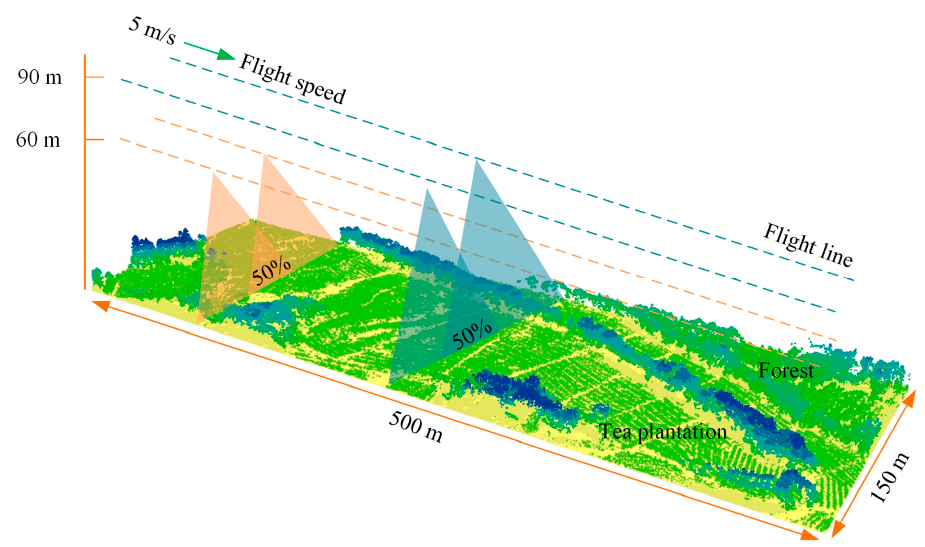
Figure 1. An illustration of a UAV-LiDAR data collection scheme in the Huashan Tea Garden (the study area). The UAV flight height affects the point cloud density and acquisition efficiency. Each flight had the same lateral overlap ratio (50%), and the number of flight lines was determined by the flight height.